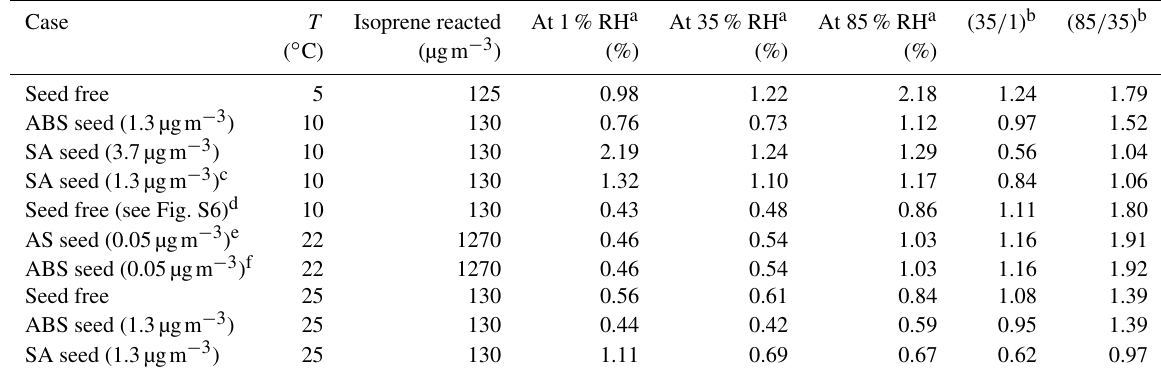
Table 3. The predicted SOA mass yields and relative yield enhancements. Note: ABS – ammonium bisulfate; SA – sulfuric acid; AS – ammonium